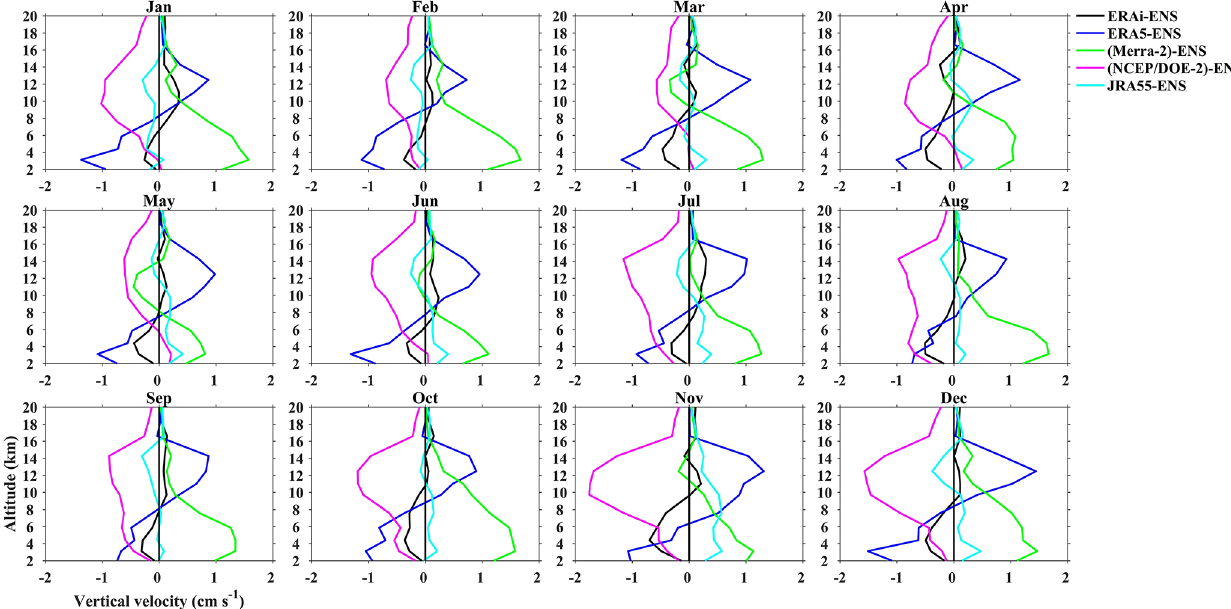
Figure 11. Same as Fig. 10 but for Kototabang from 2001 to